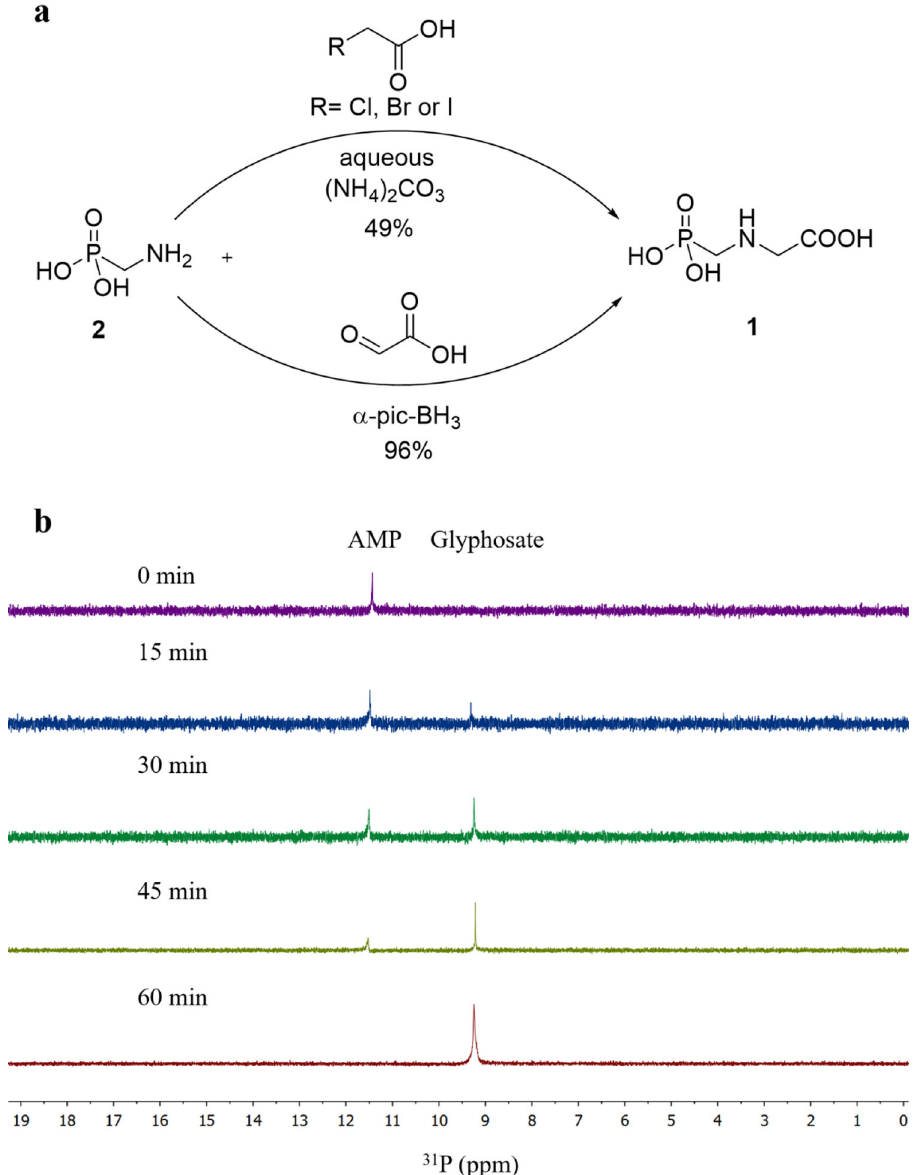
Fig. 8 Chemical conversion of 1 from 2. a Semisynthesis of 1 from microbially produced 2 . b 31 P NMR traces of reaction product of 2 with glyoxylic acid and α -pic-BH 3 (1 mmol) after incubation for 60 min at room temperature in H 2 O-AcOH (5:1)